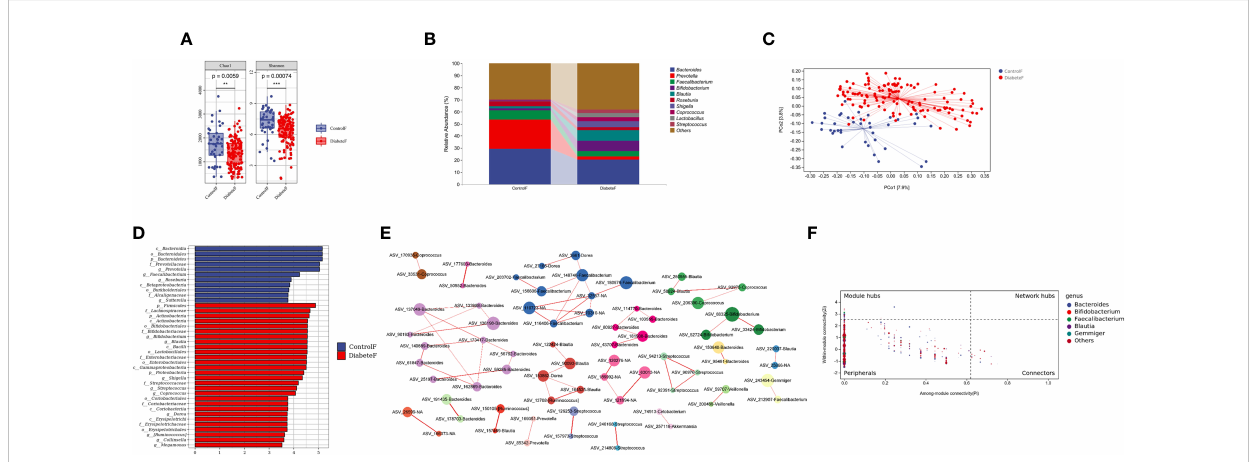
FIGURE 3 Distribution characteristics of intestinal microbiota in patients with type 2 diabetes (Figure (A) is the a Diversity results; Figure (B) is the composition of intestinal fl ora in both groups (top 10 genera); Figure (C) is the results of the PeoA analysis; Figure (D) is the LEfSe analysis results of intestinal microbiota in patients with T2DM (the LDA threshold is 3.5); Figure (E) is the co-abundance network diagram of intestinal fl ora in patients with T2DM; Figure (F) is the Zipi diagram of intestinal fl ora in patients with T2DM). **represents P<0.01 , *** represents P<0.001.